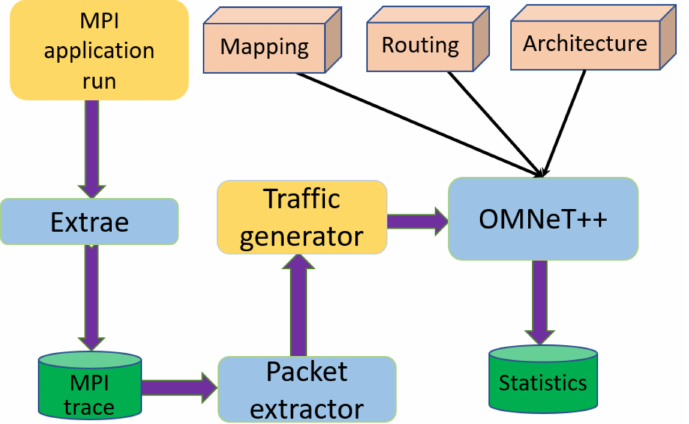
Figure 5. HPC optical network simulation